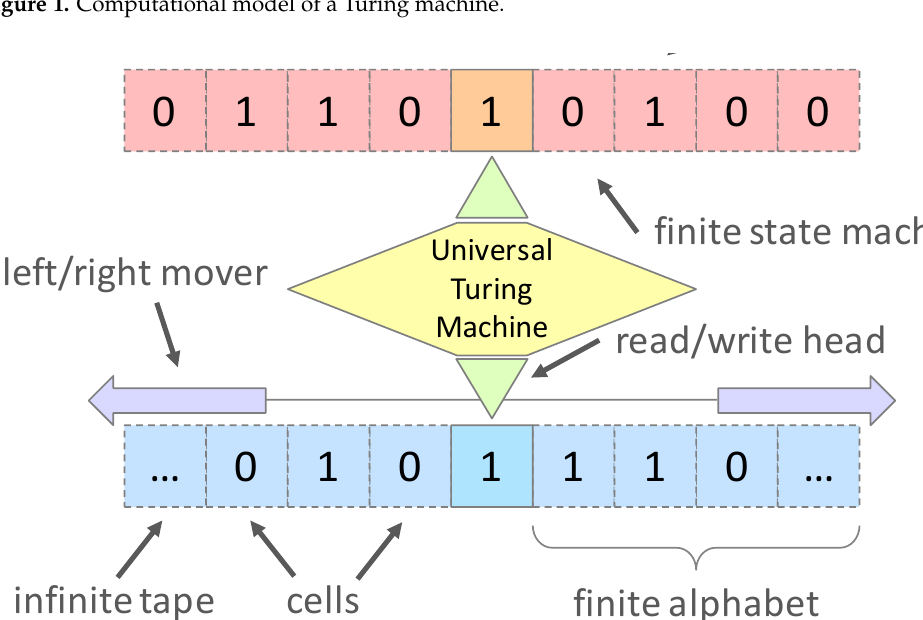
Figure 2. Computational model of a universal Turing